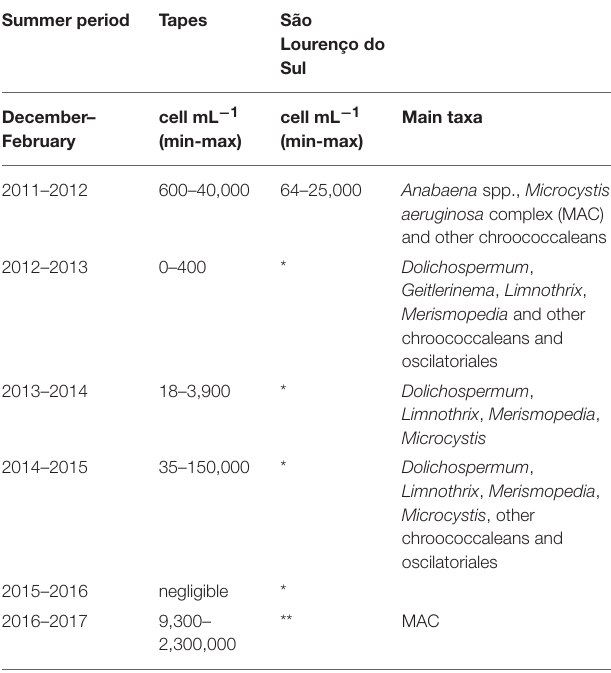
TABLE 1 | Minimum and maximum values of cyanobacteria cells mL − 1 during warmer months (December–February) near the cities of Tapes and São Lourenço do Sul, with major taxa